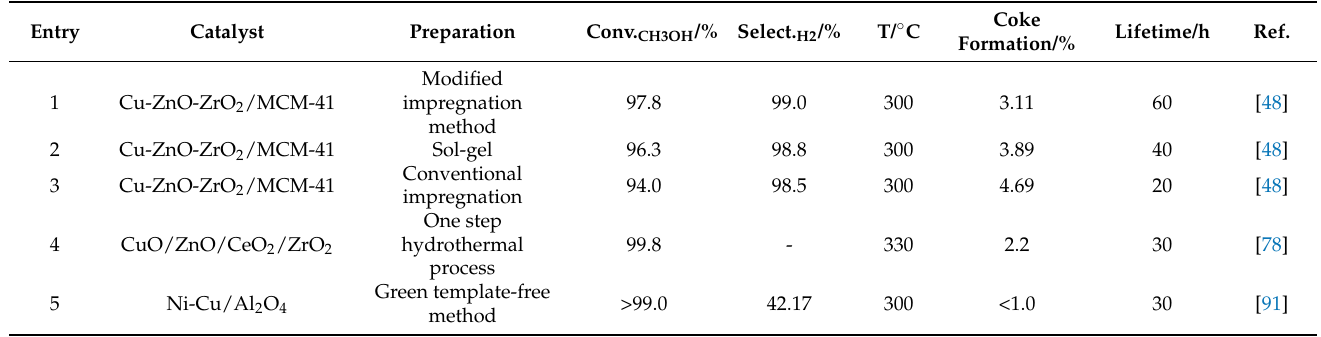
Table 1. Copper-based catalysts for MSR prepared by different preparation